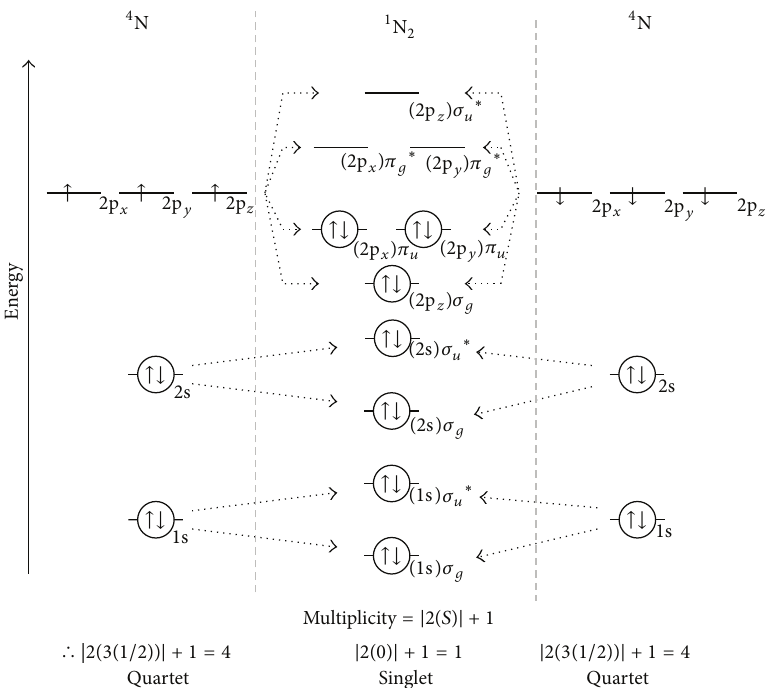
Figure 3: Combination of two quartet multiplicity nitrogen atoms ( 4 N; the superscript 4 indicates multiplicity) to yield singlet multiplicity molecular nitrogen ( 1 N 2